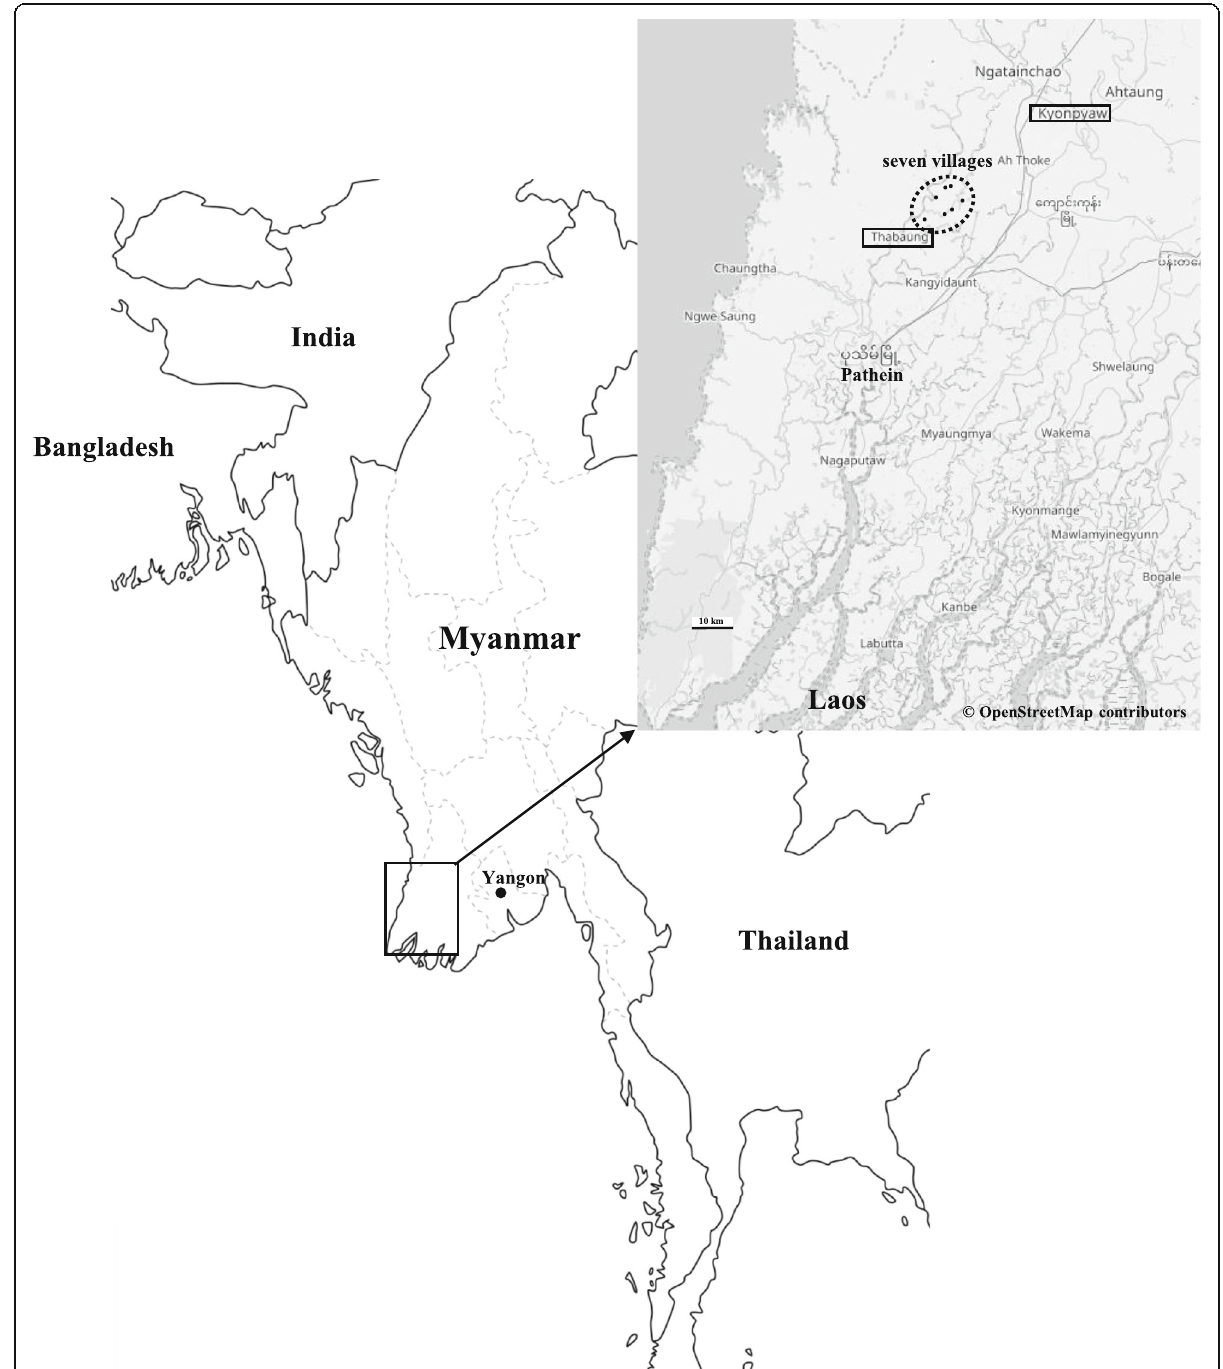
Fig. 1 A map of Myanmar. The Thaboung and Kyonpyaw townships are indicated by square boxes. The location of the seven villages is indicated by an ellipse (dashed Two-point Discriminator (Baseline, USA). The palmar surface of the right index finger tip was tested. Partici- pants kept their eyes closed and were told that one or two ends of the aesthesiometer would touch their finger in a random sequence. In each trial, the neurologist